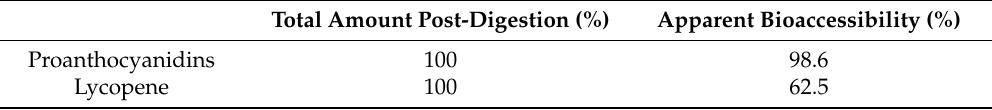
Table 4. Total amount and bioaccessible fraction of PCA and LYC, expressed as a percentage of the